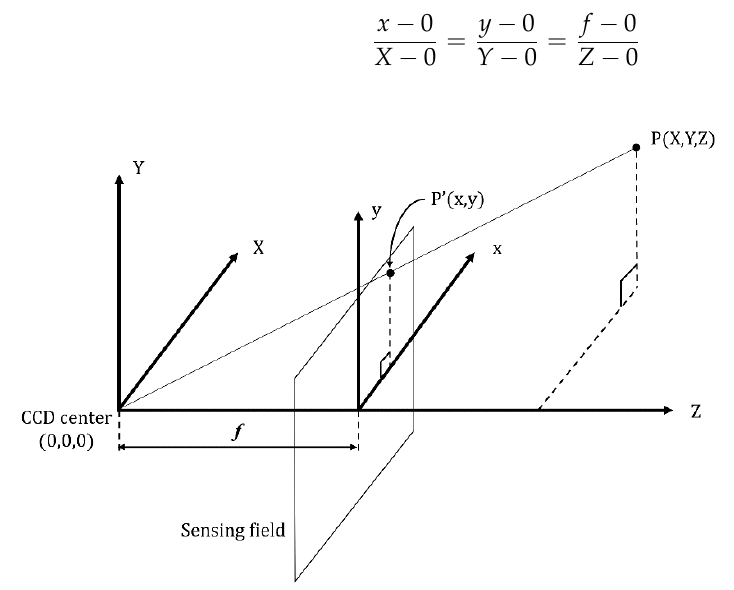
Figure 5. Vector diagram of the CCD center and the target object when